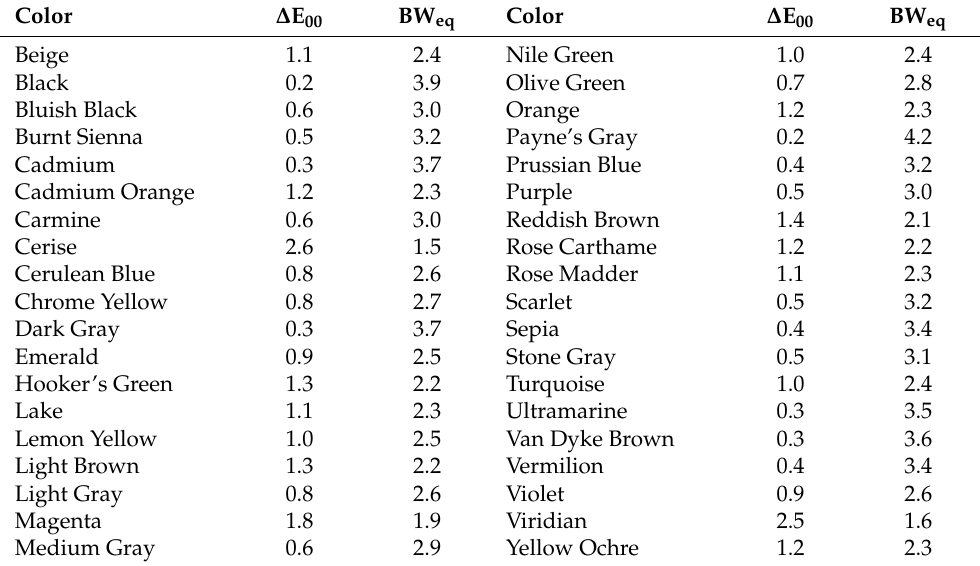
Table 3. ∆ E00 values obtained for 38 Dr. Ph. Martin’s Synchromatic Transparent Water Colors after 600 secs of illumination with MFT and the resulting BWeq scores from exponential